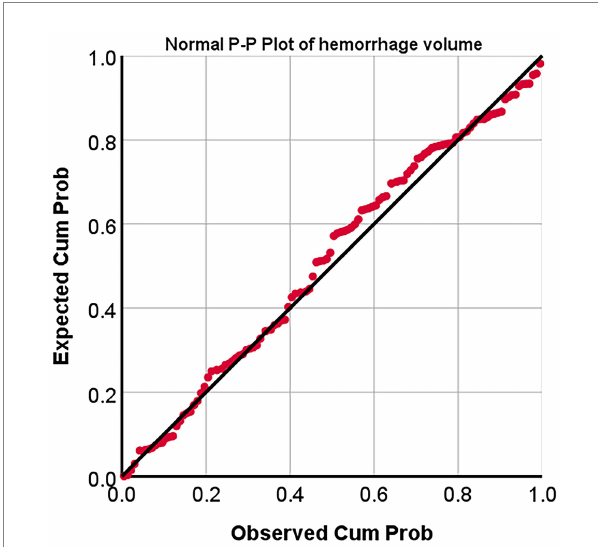
FIGURE 6 Normal probability-probability Plot (p–p plots) of hemorrhage volumes. P–P Plot, probability-probability Plot; Expected cum prob., Expected cumulation probability; Observed cum prob., Observed cumulation probability.